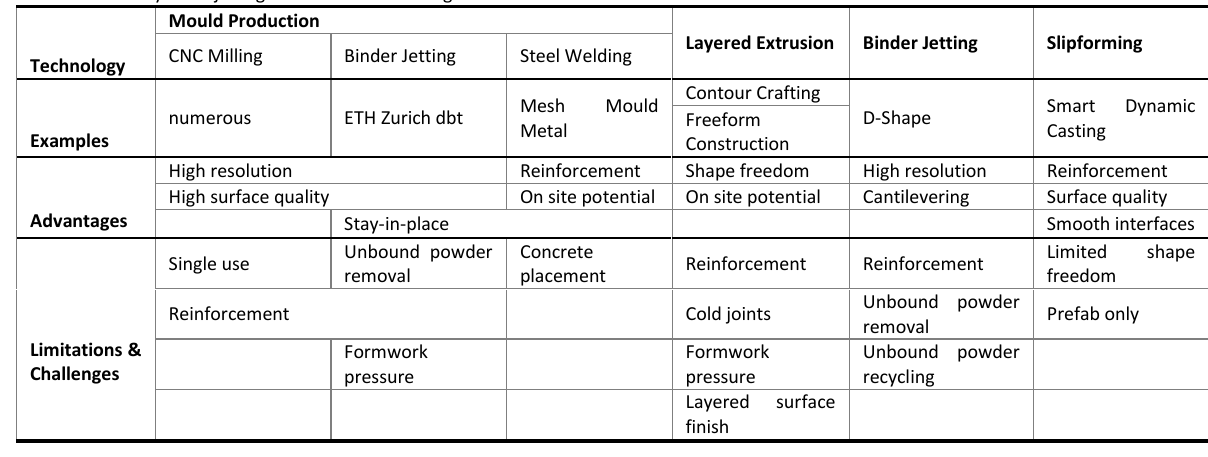
Table 1: Summary of major digital concrete technologies to